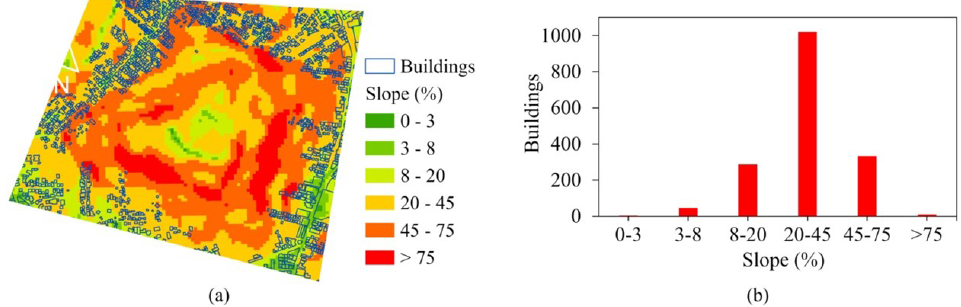
Figure 11. Building footprints and slope in the area of interest (a) and (b) number of buildings per slope